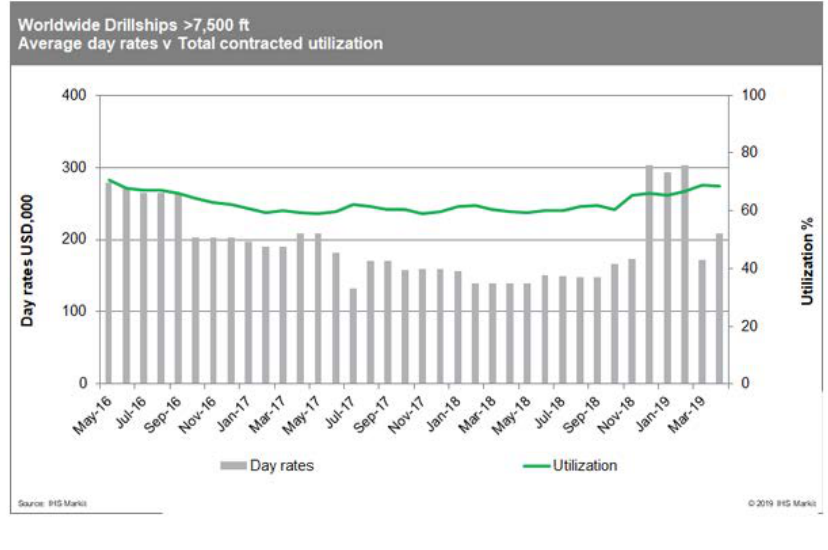
Figure 6. Offshore rig day rates [8,9]. Figure 6. O ff shore rig day rates